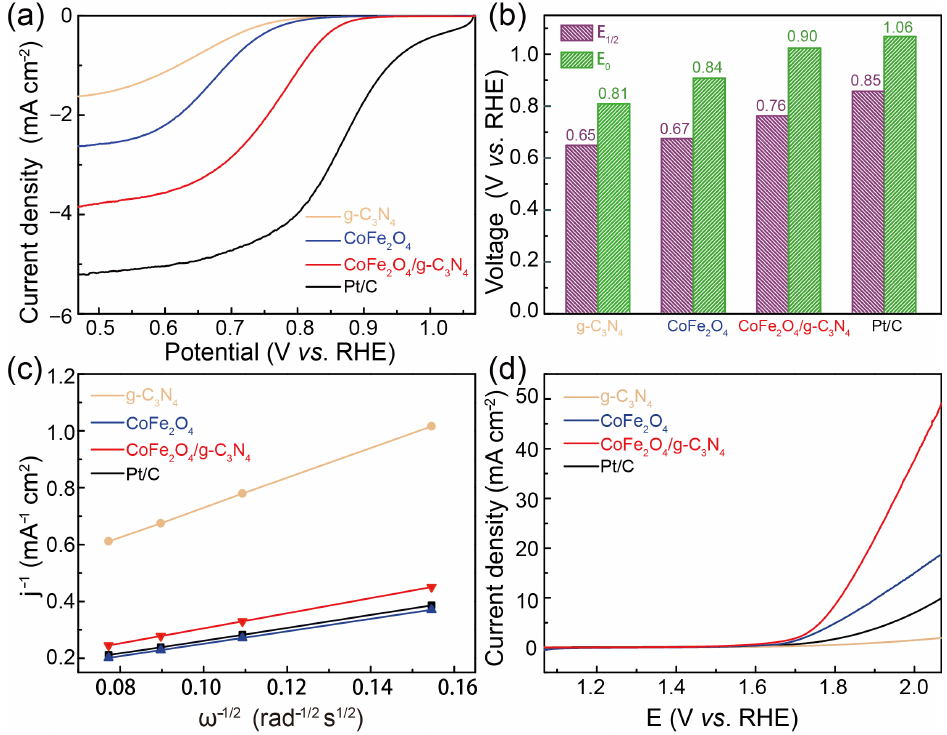
Figure 3. ( a ) ORR polarization curves; ( b ) the results summary of E 1/2 and E 0 ; ( c ) Koutecky-Levich plots; ( d ) OER curves of g-C 3 N 4 , CoFe 2 O 4, CoFe 2 O 4 /g-C 3 N 4 , and Pt/C